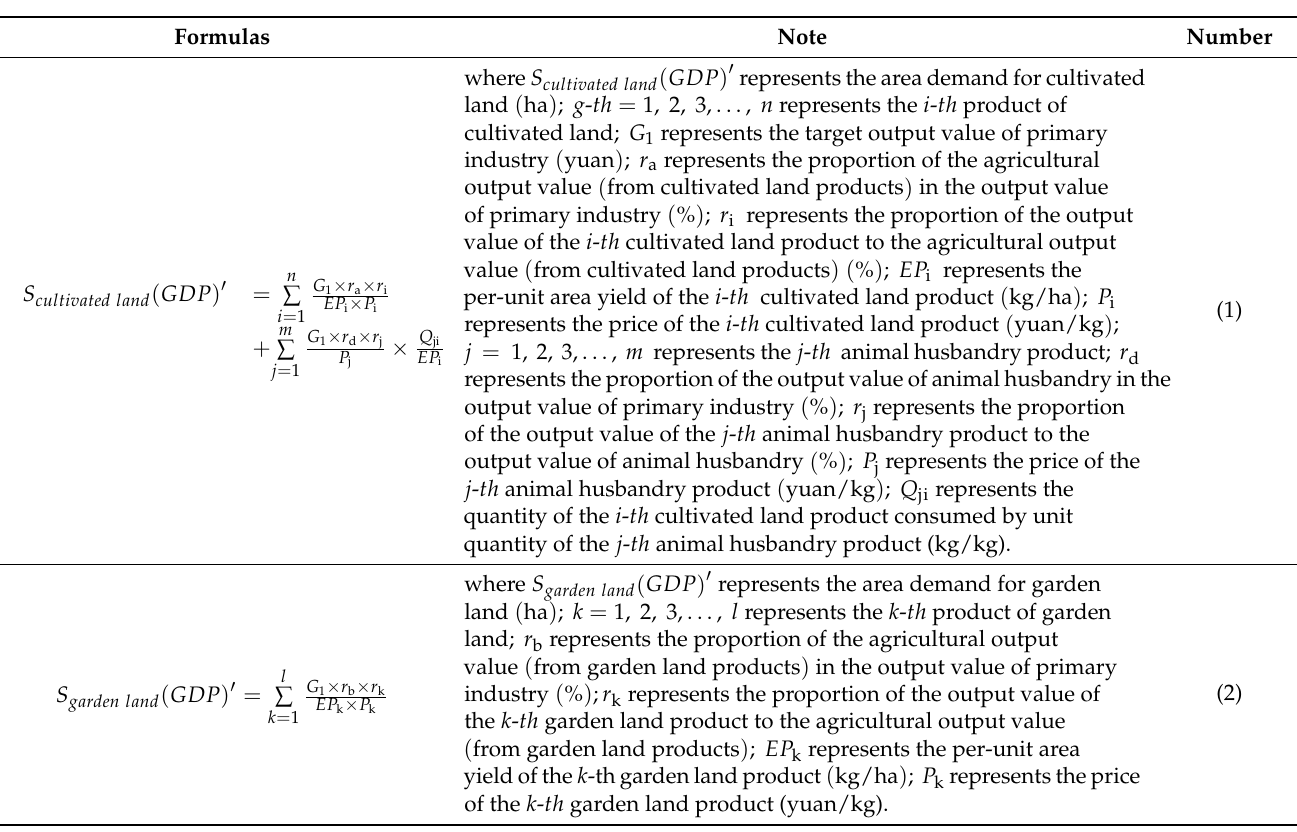
Table 3. Formulas for calculating the demand for land to realize